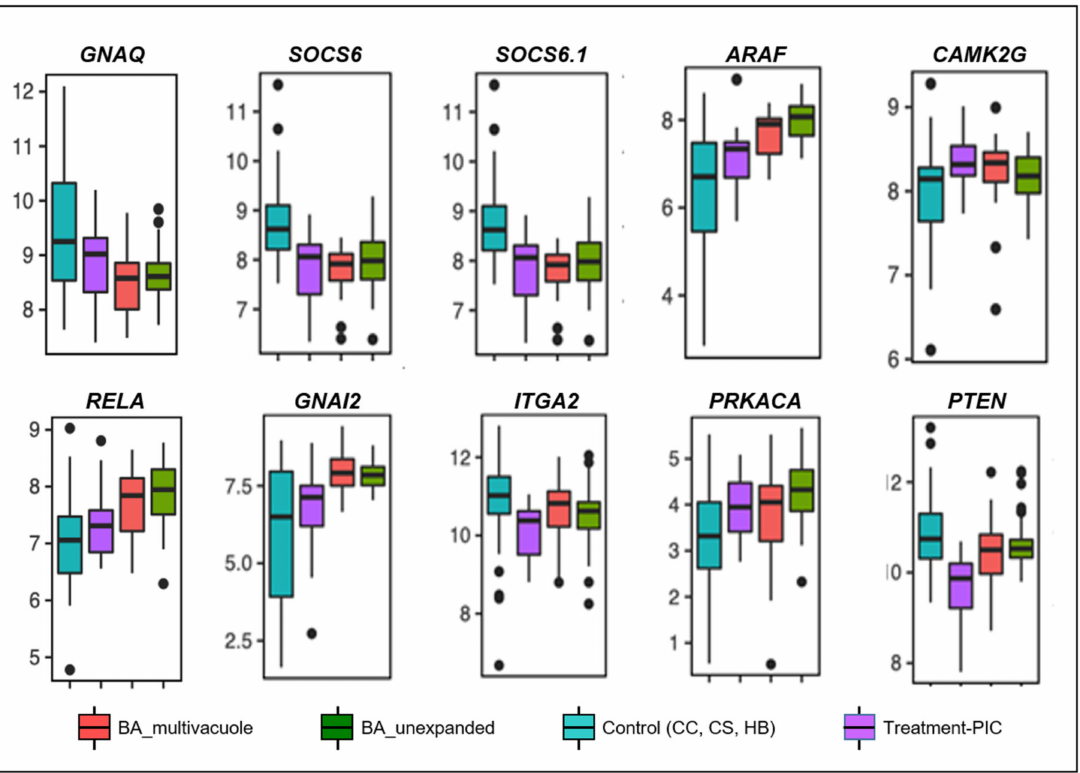
Figure 3. Boxplot showing the expression patterns of several genes that are involved in immune- mediated chemokines/cytokines signaling pathway and cellular metabolism that are differentially regulated in poly I:C treatment and BA at p < 0.05 (two-tailed Student’s t